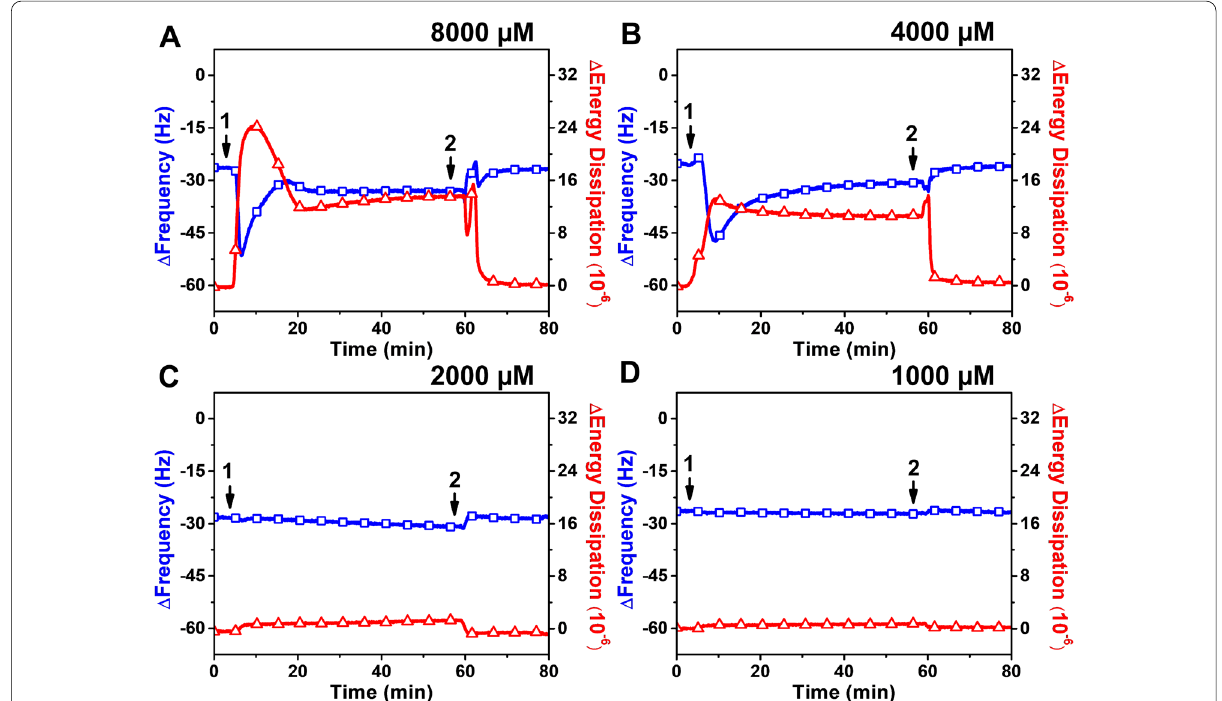
Fig. 3 QCM‑D tracking of undecanoic acid addition to supported lipid bilayer platform. Time‑resolved Δ f (blue line with squares) and Δ D (red line with triangles) shifts are presented for treating the SLB with ( A ) 8000 µM, ( B ) 4000 µM, ( C ) 2000 µM, and ( D ) 1000 µM undecanoic acid. The initial baseline measurements were consistent with the typical QCM‑D values for supported lipid bilayer formation on a silica surface. After the baseline signals were stabilized for 5 min, undecanoic acid was continually added (arrow 1) for around 50 min before a buffer washing step was performed (arrow 2)